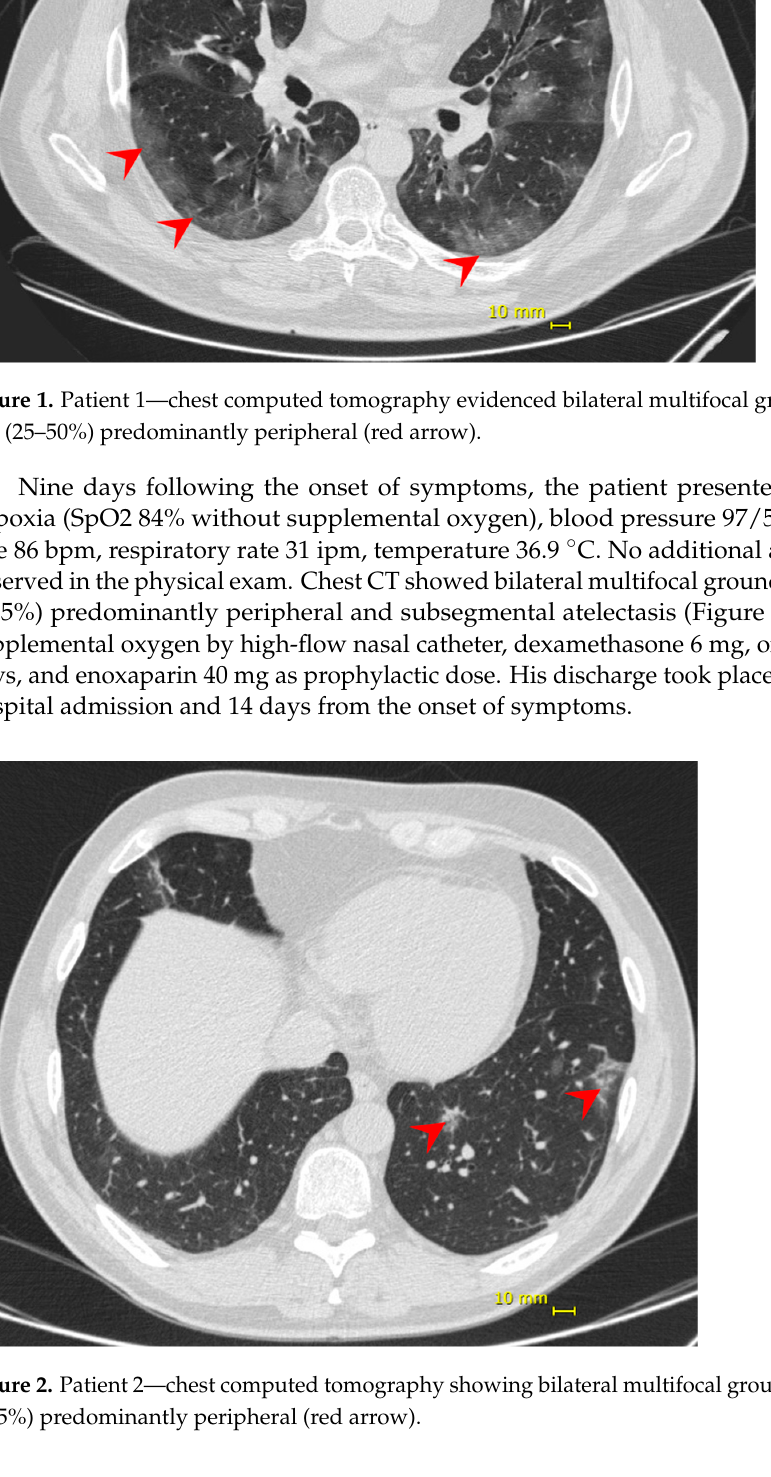
Table 1. Clinical and laboratory findings during the progressing of COVID-19 in two patients vaccinated with Coro- naVac. In bold: out of range results from reference values. Patient 1